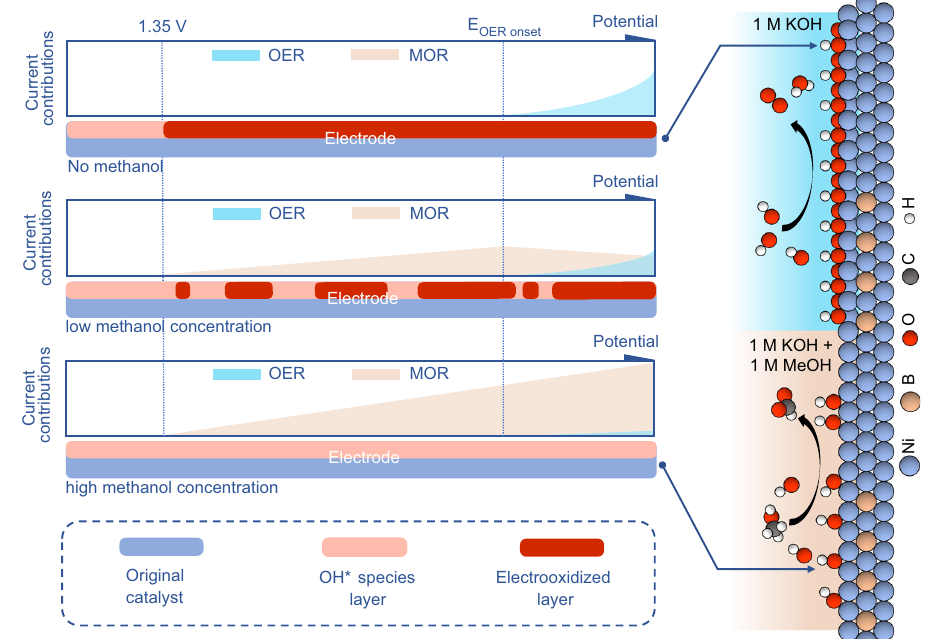
Fig. 7 | Comparison of reaction processes. Schematic representation of the methanol oxidation process on nickel boride/nickel and the evolution of the